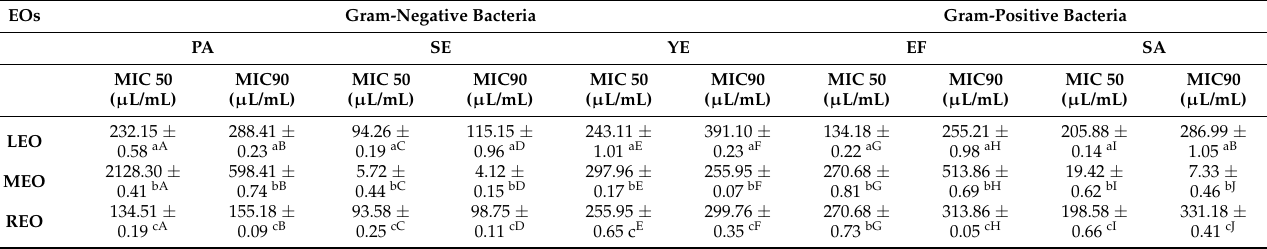
Table 5. Antimicrobial activity of EOs expressed as the minimum inhibitory concentration (MIC) in µ L/mL against Gram-negative and Gram-positive bacteria.